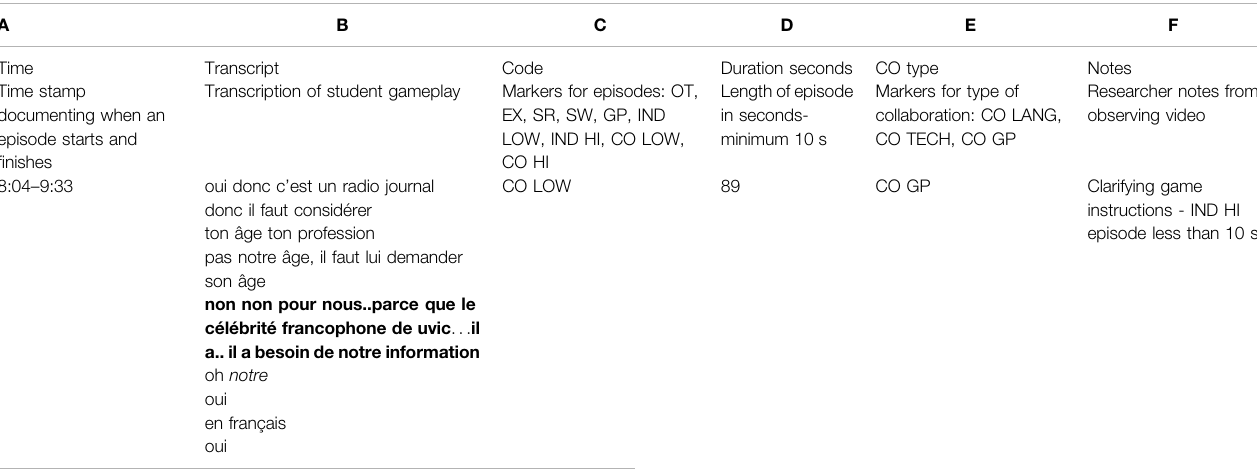
TABLE 2 | Spreadsheet coding example Fran 160.